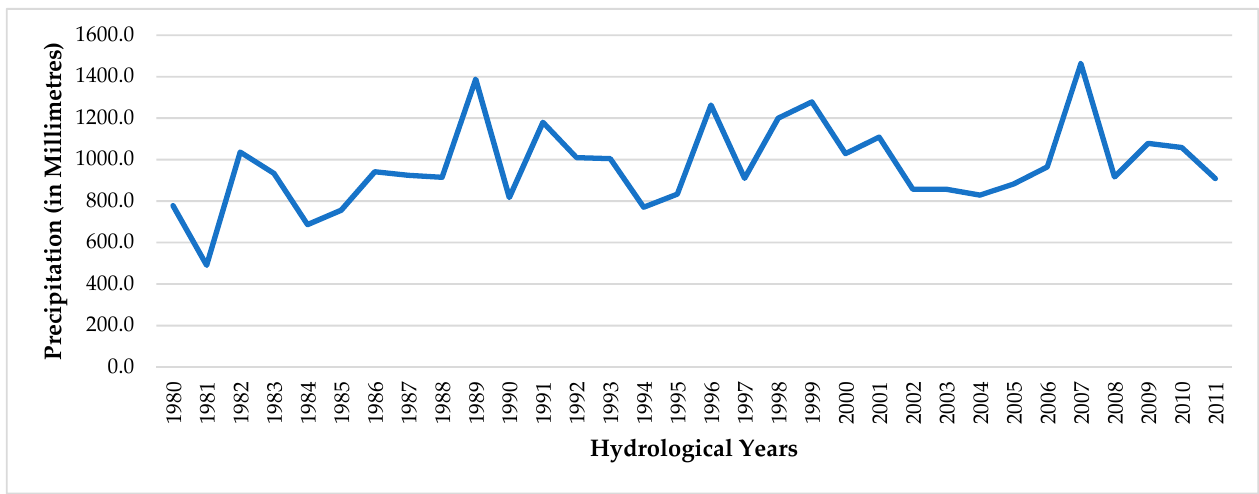
Figure 2. Annual (monthly totals) Precipitation for Zuarungu (UER) (1980–2011). Source: Author (2021).